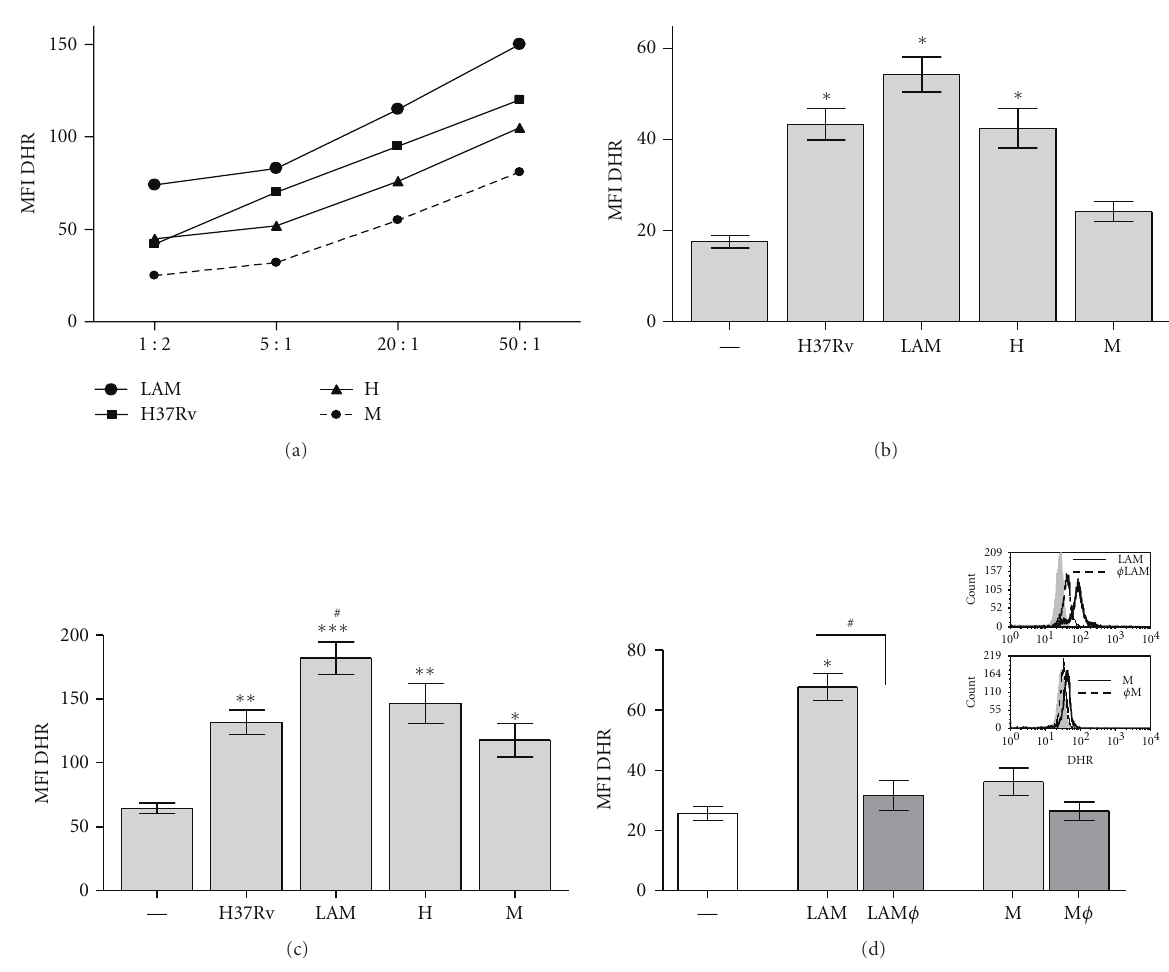
Figure 5: ROS production induced by Mtb strains in PMN. (a) PMNs treated with DHR were incubated with Mtb strains and MFI of 123rodhamine was measured by flow cytometry. Di ff erent Mtb : PMN ratios were tested (1:2, 5 :1, 20 :1, and 50: 1) and a representative experiment out of three is shown. (b) ROS production induced at low Mtb :PMN ratio (1:2); results are expressed as media ± SEM ( n = 20), statistical di ff erences: control versus LAM, H37Rv, and H: ∗ P < 0 . 001. (c) ROS production induced at 50:1 Mtb :PMN ratio; results are